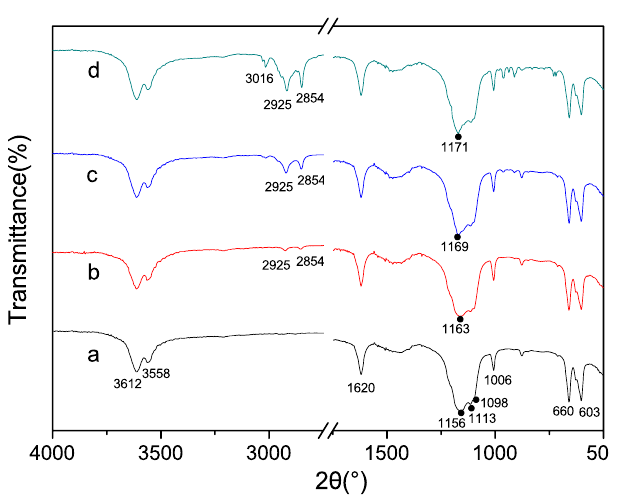
Figure 6. FT-IR spectra of α -HH whiskers prepared with different CTAB concentrations in glycerol (65 wt%)- water solutions with 5% KCl (by weight of FGD gypsum) at 90 °C for 45 min (( a ) 0; ( b ) 0.05%; ( c ) 0.15%; ( d )